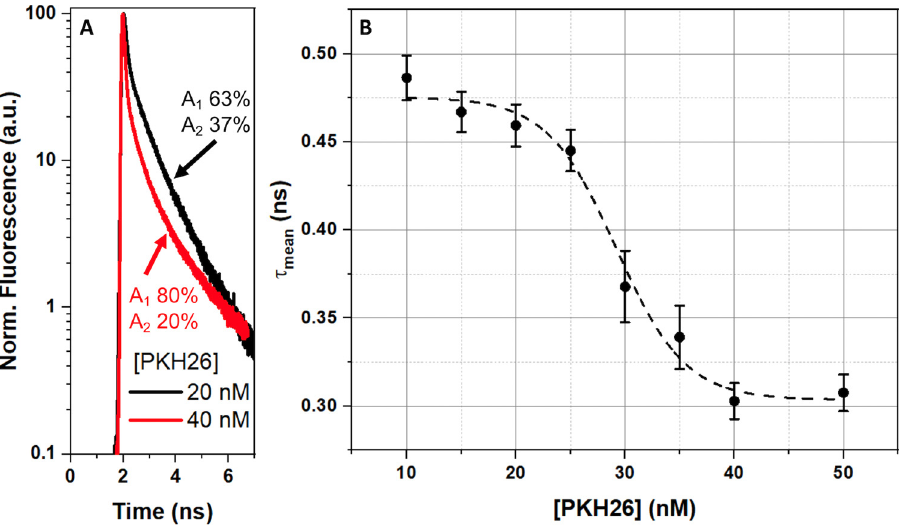
Figure 3. Time-resolved fluorescence measurements of RBC, labeled with PKH26 lipophilic dye at different concentrations: ( A )—normalized on the maximum total fluorescence intensity decay curves; ( B )—mean amplitude-weighted fluorescence lifetime ( τ mean ) values. Amplitudes A 1 and A 2 were obtained by approximation of the curves with a double-exponential decay function. Dashed line represents approximation with a sigmoid function.